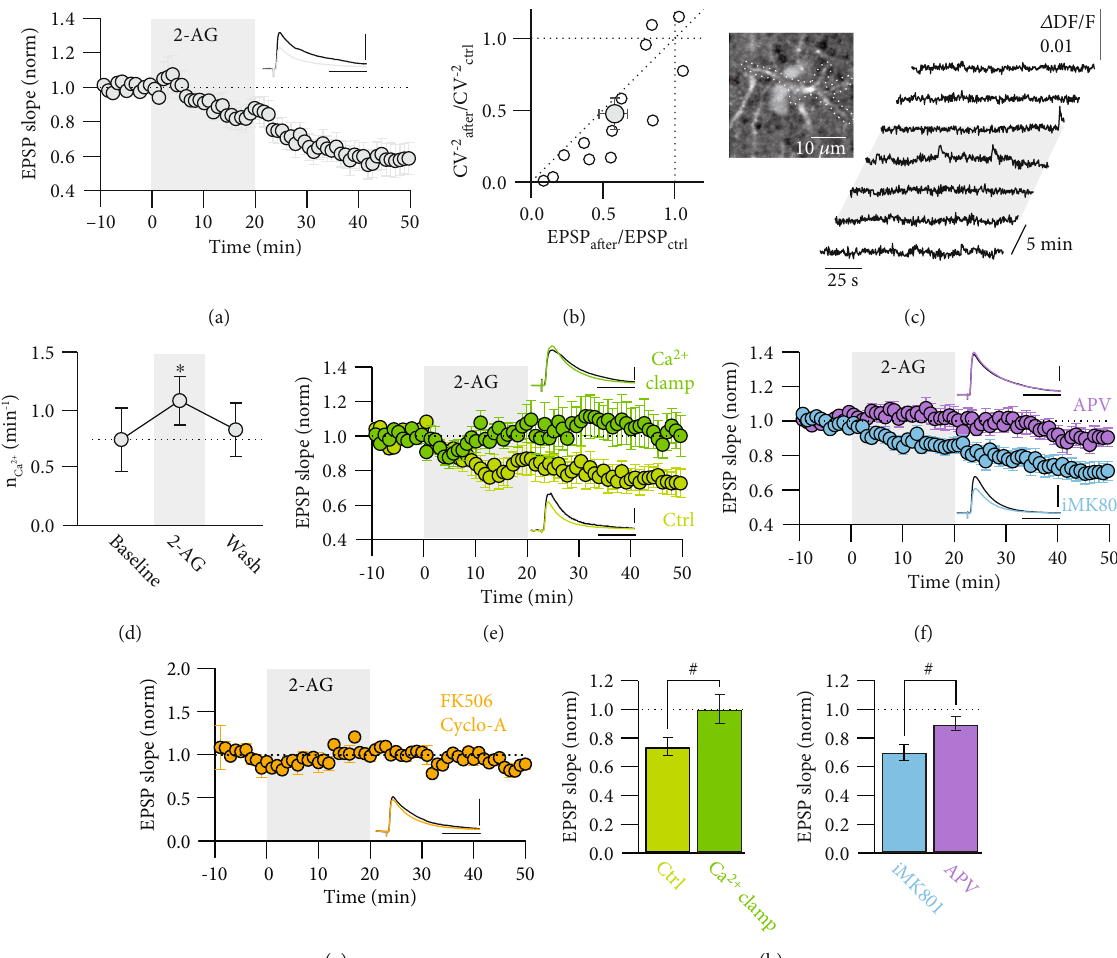
Figure 1: 2-AG mediated LTD requires astrocyte Ca 2+ signaling and preNMDARs. (a) Time course of normalized and averaged EPSP slope measured in L2/3 pyramidal neurons before, during (0 – 20min, shaded area) and after bath application of 2-AG ( n = 13 ). Inset, representative average EPSP during baseline (black) and after 2-AG (grey). (b) Relative change of coe ffi cient of variation of EPSP slope after bath application of 2-AG as a function of corresponding changes in EPSP slope. The relation is almost linear, indicating a presynaptic locus of eCB-LTD expression. Open circles represent individual experiments, and fi lled circle represents the average ( n = 13 ). (c) Two-photon fl uorescence image of an astrocyte in L2/3 of the somatosensory cortex loaded with the Ca 2+ indicator Rhod-2. Traces to the right show Ca 2+ fl uctuations in the astrocyte before, during, and after bath application of 2-AG (shaded area). (d) Summary of the average number of Ca 2+ transients during the time course of the experiment ( n = 12 ). ∗ p < 0 : 05 for the e ff ect of time on Ca 2+ transient number by Student ’ s paired t -test. (e) Normalized and averaged EPSP slope over time in L2/3 pyramidal neurons, while an adjacent astrocyte was infused in the whole-cell recording con fi guration with either a control (Ctrl, n = 8 ) and or Ca 2+ clamp solution ( n = 9 ). Inset, representative average EPSP during baseline (black) and after 2-AG in control (light green) or Ca 2+ clamp (dark green) conditions. (f) Normalized and averaged EPSP slope over time during bath application of APV ( n = 13 ) or intracellular infusion of MK801 ( n = 24 ) into the pyramidal neuron (iMK801). Inset, representative average EPSP during baseline (black) and after 2-AG in the presence of APV (purple) or iMK801 (blue). (g) Normalized and averaged EPSP slope in the presence of the calcineurin inhibitors FK506 and cyclosporin-A ( n = 2 ). Inset, representative average EPSP during baseline (black) and after 2-AG (orange). (h) Bar graph summary of experiments shown in (e) and (f). In the astrocyte Ca 2+ clamp condition, eCB-LTD was abolished. APV blocked eCB-LTD, while intracellular block of postsynaptic NMDARs with MK801 had no e ff ect. # p < 0 : 05 by one-way ANOVA. All data are represented as mean ± SEM . All scale bars for average EPSPs represent 40 ms and 2mV,